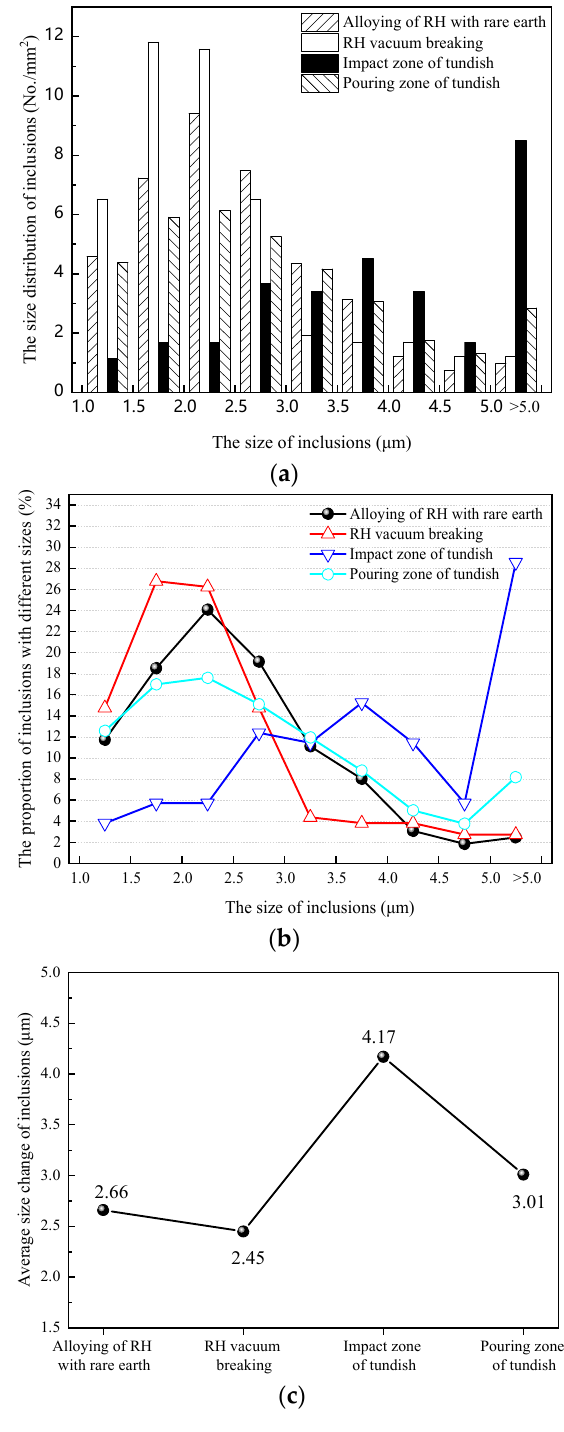
Figure 13. Size distributions and changes to inclusions in the steel. ( a ) The size distribution of inclusions, ( b ) The proportion of inclusions with different sizes, ( c ) Average size change of inclusions .